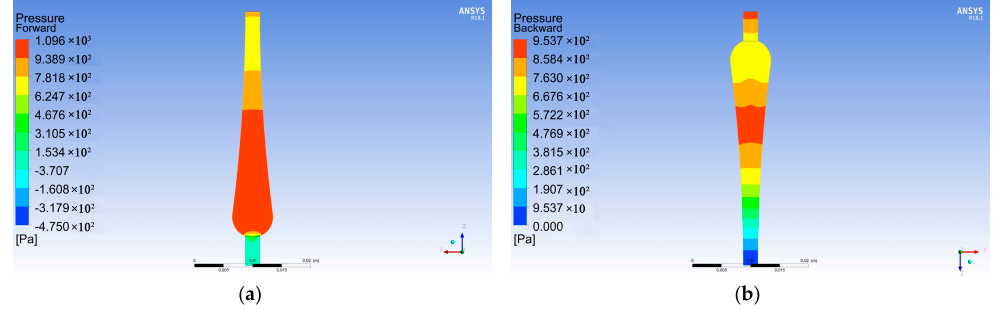
Figure 4. Pressure distribution of the streamlined flow tube. ( a ) Forward pressure distribution, ( b ) Backward pressure distribution. Appl. Sci. 2019 , 9 , x FOR PEER REVIEW